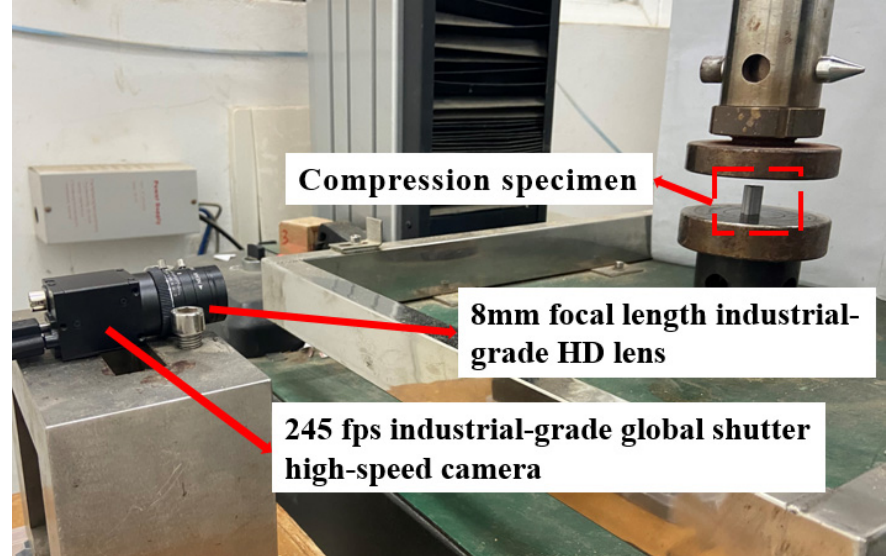
Figure 7. Site layout